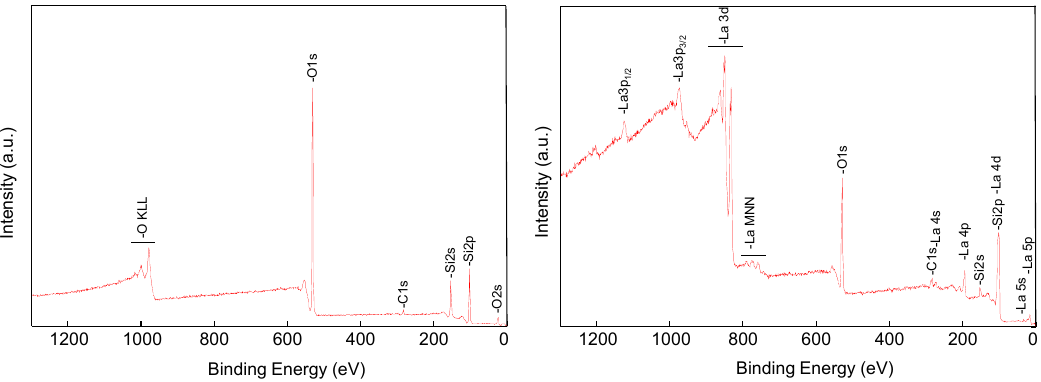
Figure 3. Survey spectra of mesoporous silica KIT-6 (left) and La(III)O-KIT-6 catalyst (2) (right).